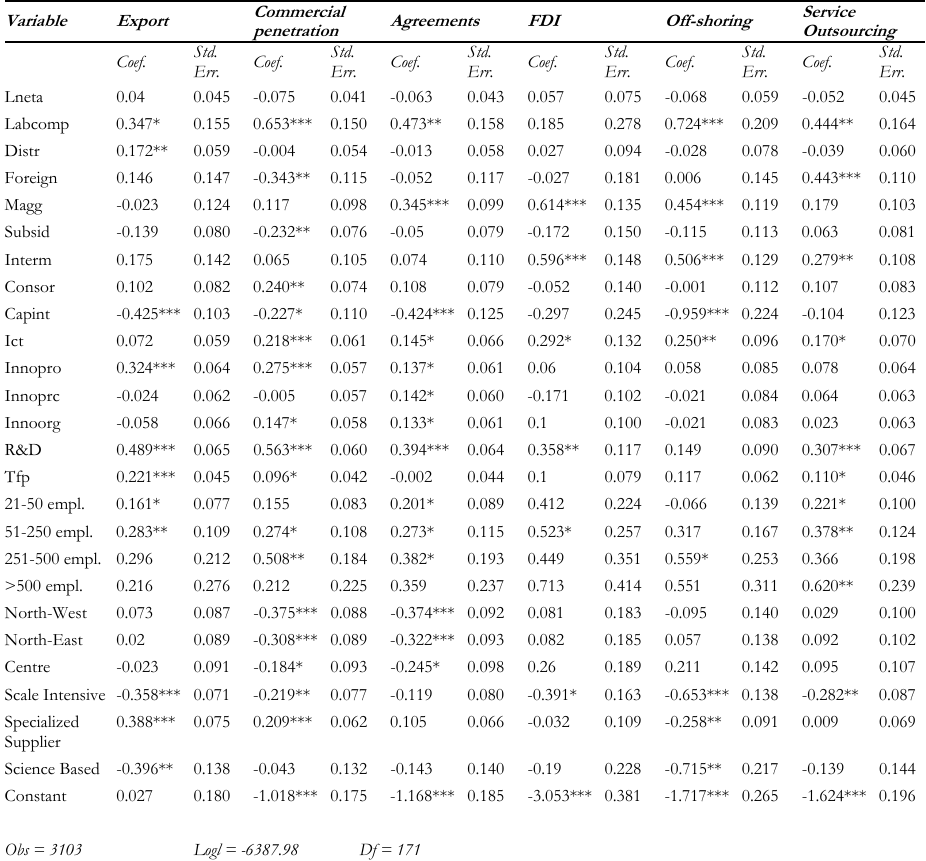
Multivariate probit estimates – SML using GHK simulator with R=300